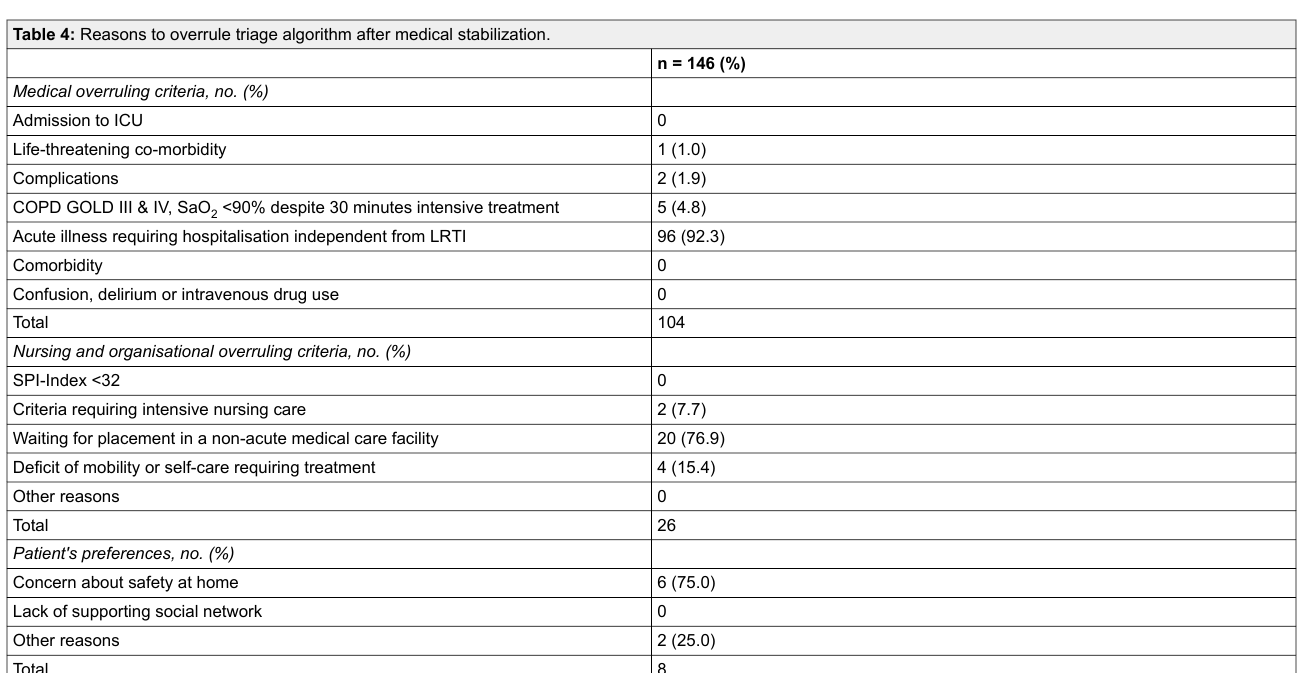
Table 4: Reasons to overrule triage algorithm after medical